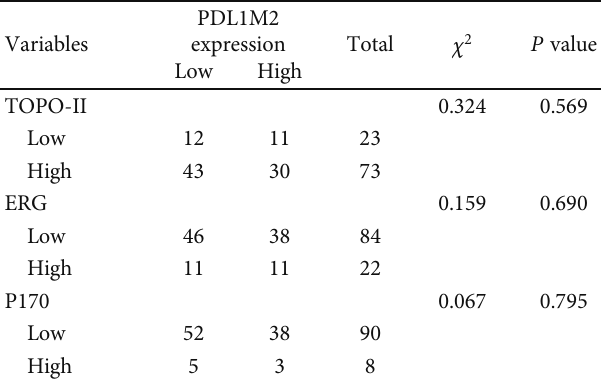
Table 3: Correlation between PDLIM2 protein expression and clinicopathological